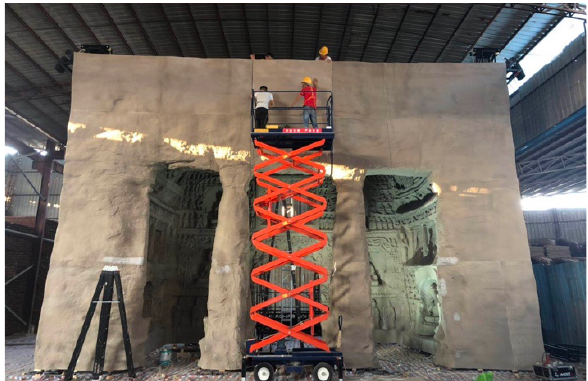
Figure 10. The full view of the replica Cave 12 of the Yungang Grottoes. Engineers are refining the exterior wall.